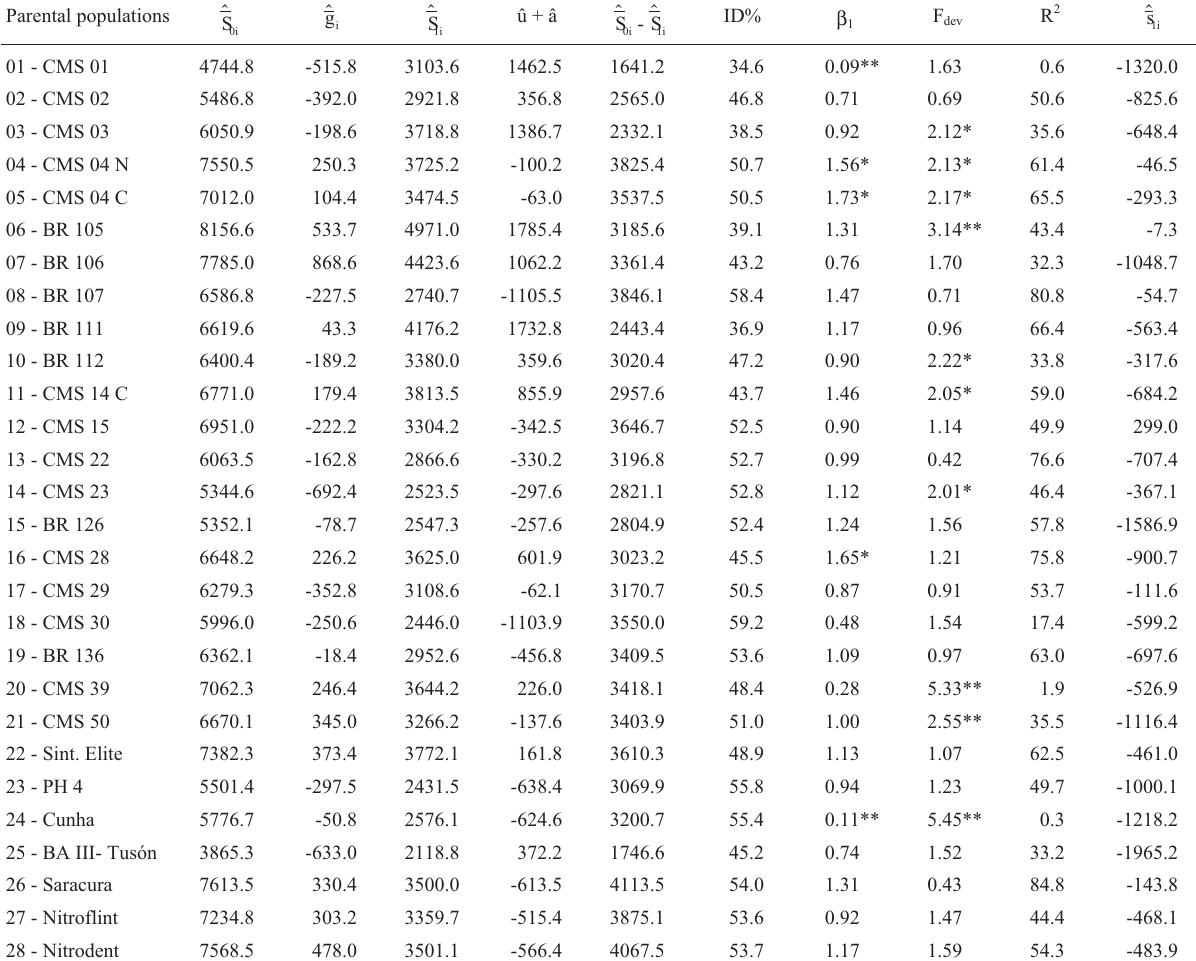
TableIII -Estimatesofthegeneralandspecificcombiningabilityeffects,inbreedingdepressionanditsstabilitycoefficientsforearweight(kg/ha)ofthe 28 maize populations assessed in the diallel in 10 environments. Parental